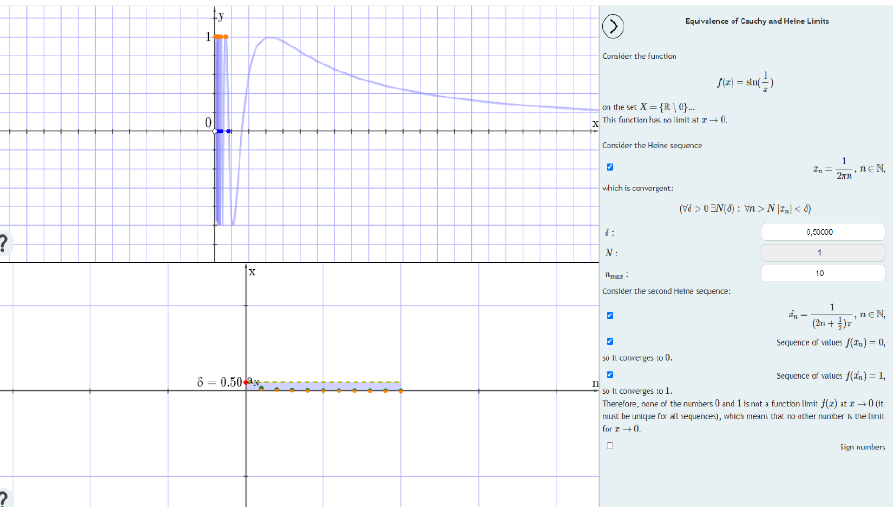
Fig. 5. Window of the «Implementation of neural network programs» subsystem in the Nomotex DLS. Course «Mathematical analysis», paragraph «The concept of the limit of a function», lecture 8, quantum Equivalence of definitions according to Cauchy and Heine. Mathematical